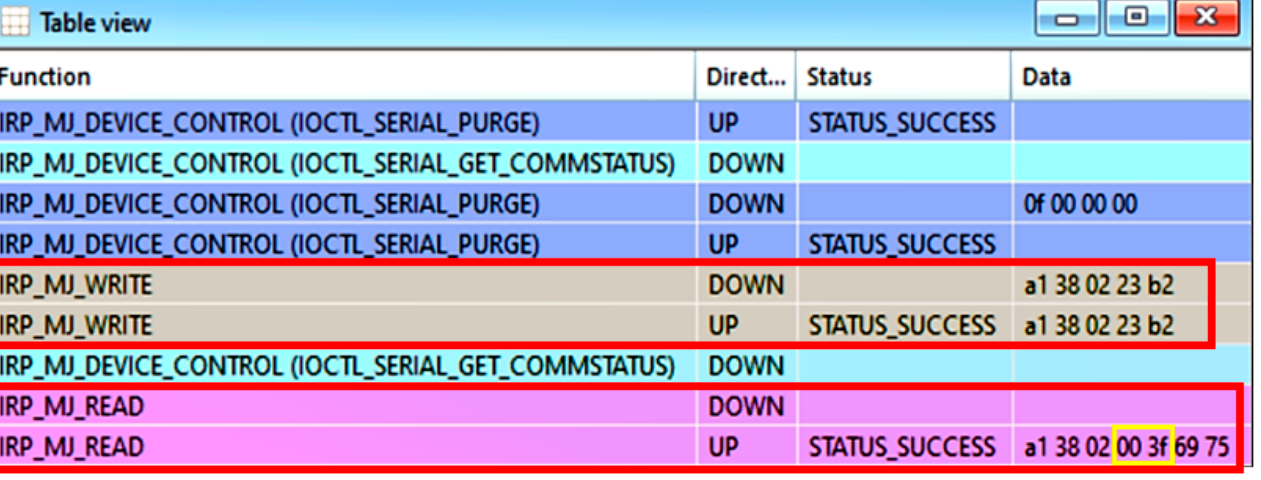
Figure 5. Example of a “WRITE” and a “READ” record on the Serial Monitor Software. Data corresponds to a Temperature Request and a Temperature Reading respectively.